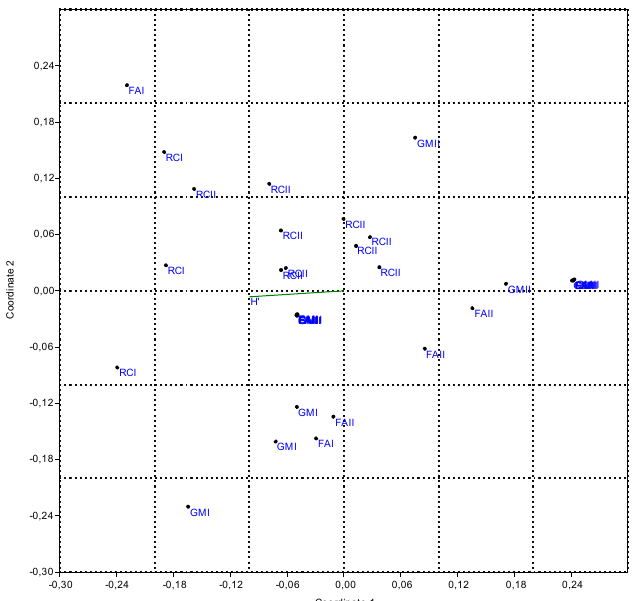
Figure 4. Two-dimensional non-metric multi-dimensional scaling ordination of weed frequencies/biodiversity (Shannon H’ diversity index) and tillage systems. FA, fallow; GM, green manure; RC, in-line/roller crimper.